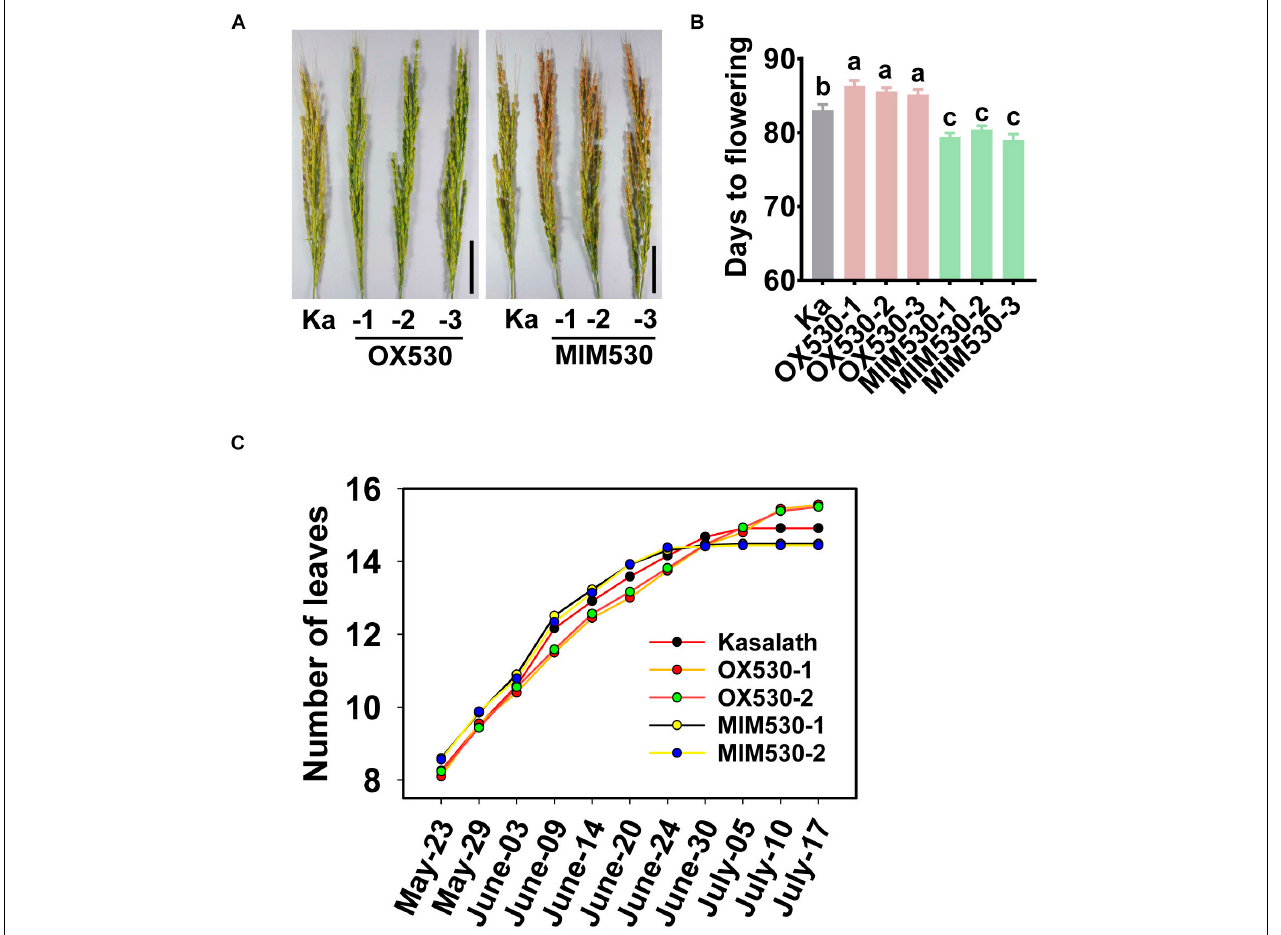
FIGURE 4 | Blocking miR530 shortens rice flowering time. (A) The panicle morphology of the Kasalath control (Ka), OX530, and MIM530. Bars = 5 cm. (B) The flowering time of the Kasalath control, OX530, and MIM530 planted in paddy yard in Wenjiang District, Chengdu City, Sichuan Province, China during the regular season from April to September in 2019. The data are shown as mean ± SD ( n = 10 independent plants). Different letters above the bars indicate significant differences ( P < 0.05) as determined by the one-way ANOVA analysis. (C) Quantification of leaf number per main tiller of the Kasalath control, OX530, and MIM530 lines. The data are shown as mean ± SD ( n = 10 independent